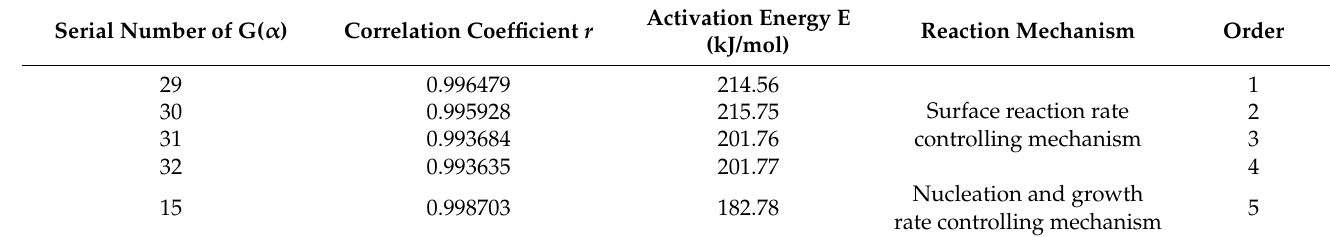
Table 3. Fitting results for the top five G( α ).